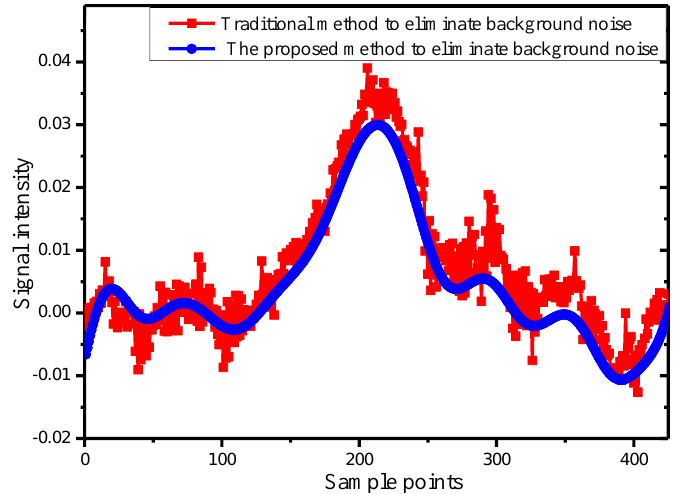
Figure 6. Signal obtained after background noise removal.